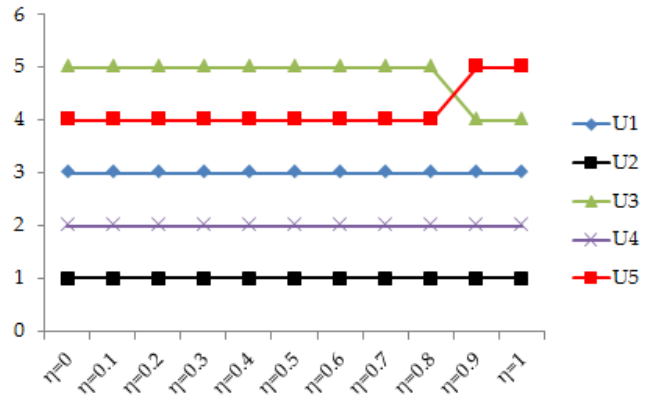
Figure 10. Alternatives final rankings of sensitivity analysis.